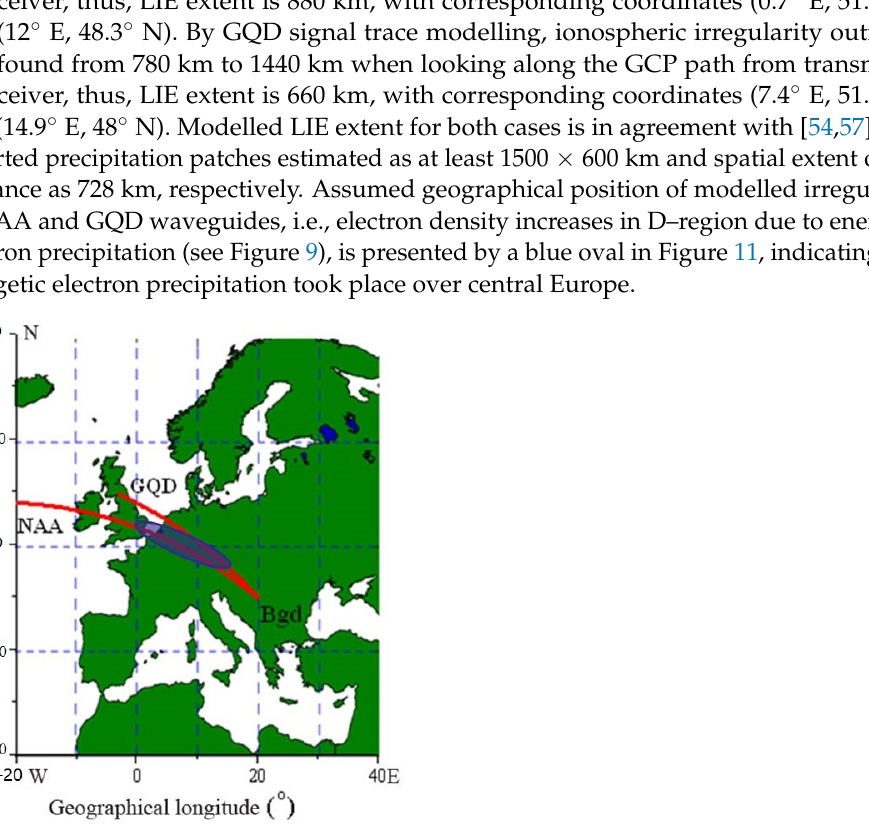
Figure 11. Geographical position of modelled LIE (blue oval) related to energetic electron precipitation on 16 November 2004.